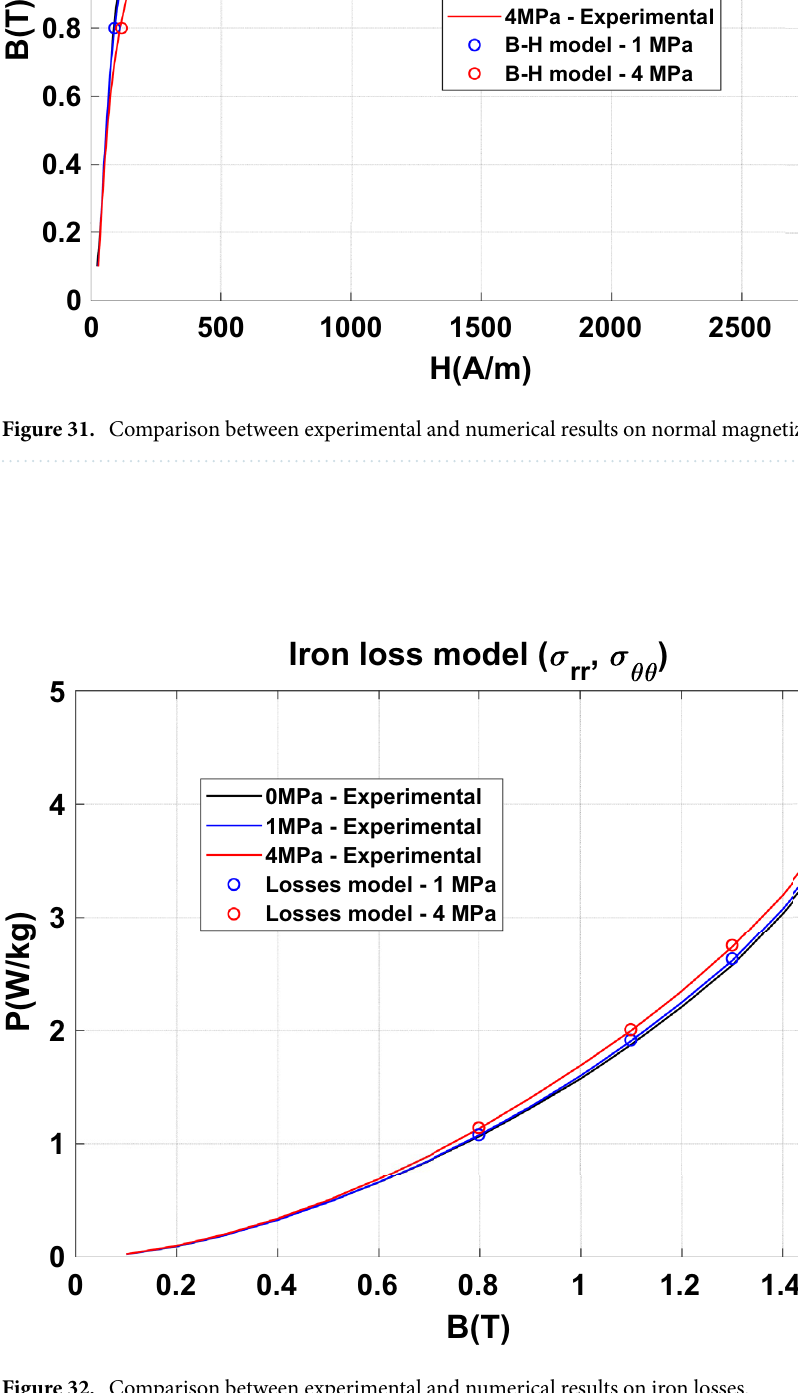
Figure 32. Comparison between experimental and numerical results on iron